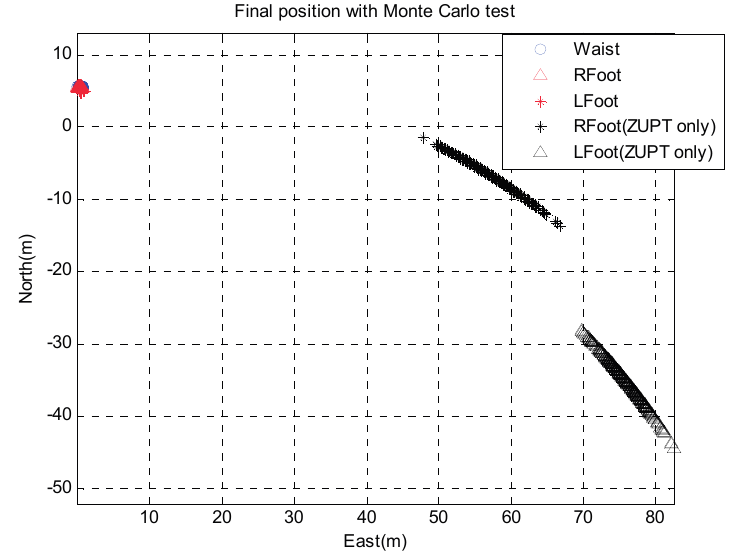
Figure 18. Final position of ZUPT algorithm and proposed algorithm for Monte Carlo simulation 500 times with random gyro drift error of 0.01°/s